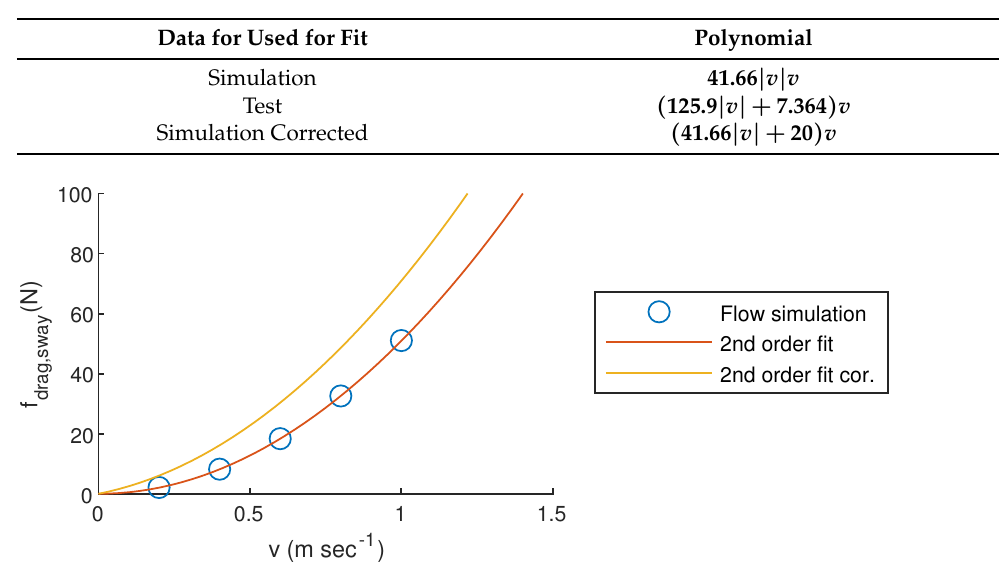
Figure 6. Comparison on flow simulation and experimental data for standard configuration BlueROV2. Table 5. 2nd order polynomials for Y v ( v ) .